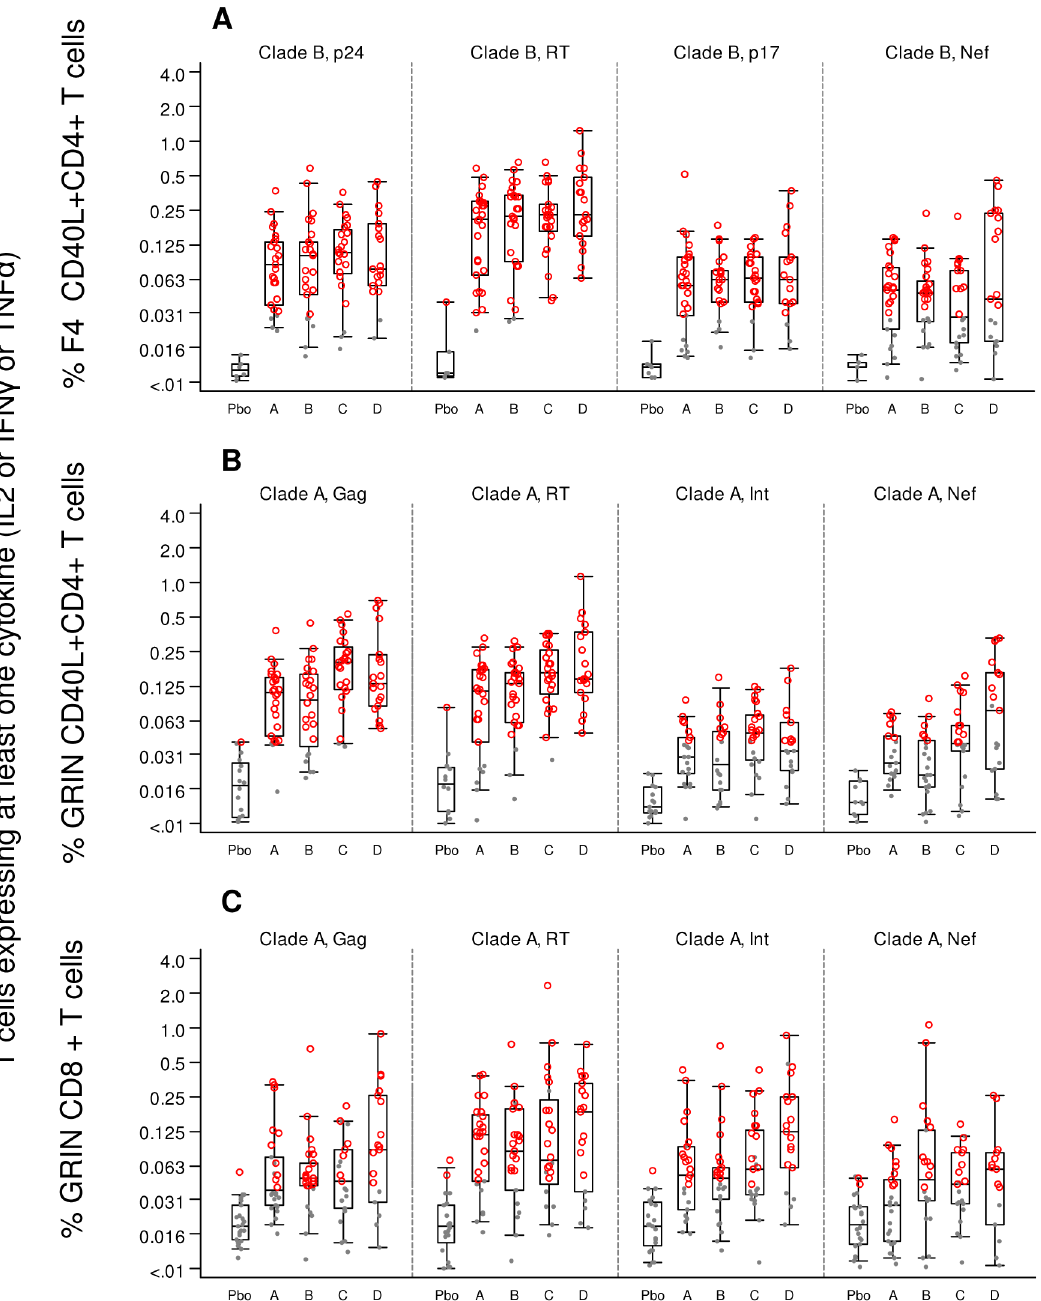
Fig 7. CD4 and CD8 responses to individual peptide pools 4 weeks after last vaccine (M5). The y-axis shows the magnitude of CD4+ and CD8+T-cells on a half-log scale across groups A-D for A. individual F4-specific CD40L+CD4+ T cell responses (clade B p24, RT, Nef and p17 peptide pools); B. individual GRIN-specific CD40L+CD4+ T cell responses (clade A Gag, RT, Int and Nef peptide pools) and C. individual GRIN-specific CD8+ T cell responses (clade A Gag, RT, Int and Nef peptide pools). The overlaid box-and-whisker plot summarizes the overall responses (i.e., the median, 1st and 3rd quartiles and 5 th , 95 th Percentiles). Pbo; placebo groups were combined across groups